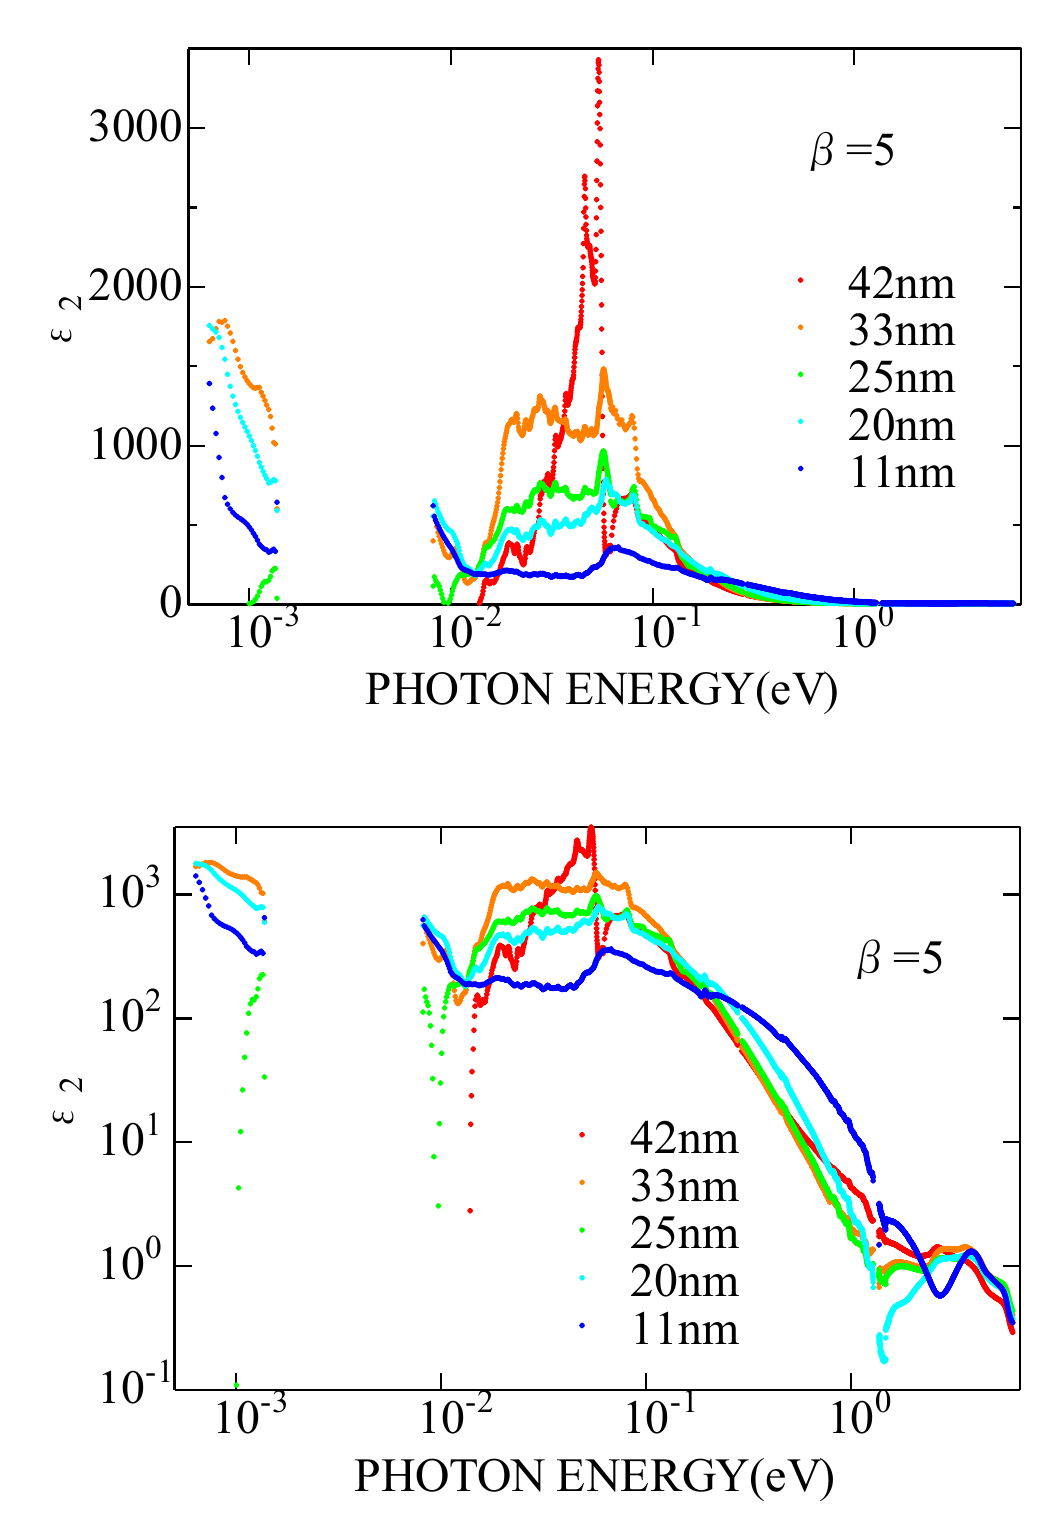
Figure 5: Dielectric constant spectra (imaginary part) of NPG membranes on quartz substrates. The above figure is semi-log plot and the below one is log-log plot. The extrapolation exponent index of the reflectivity at high energy β =